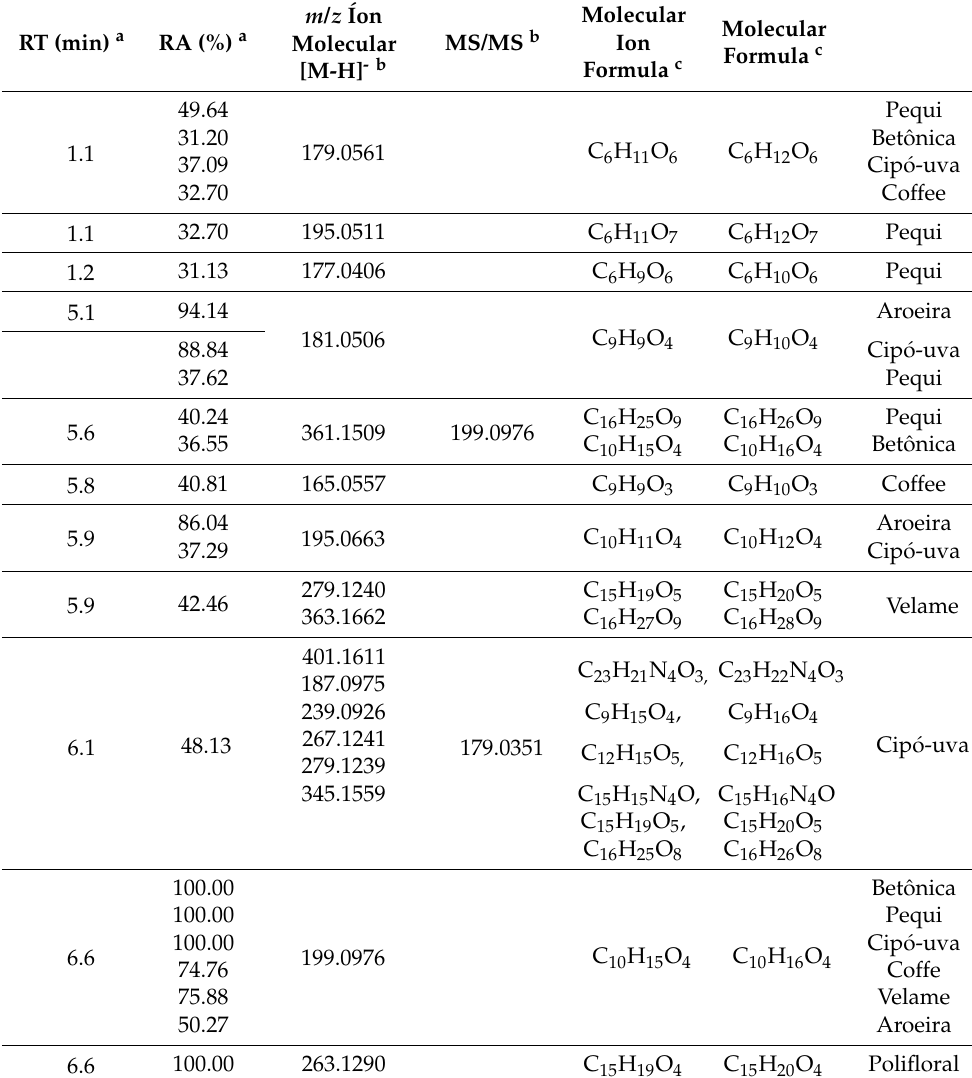
Table 5. Data from all samples for analyses of